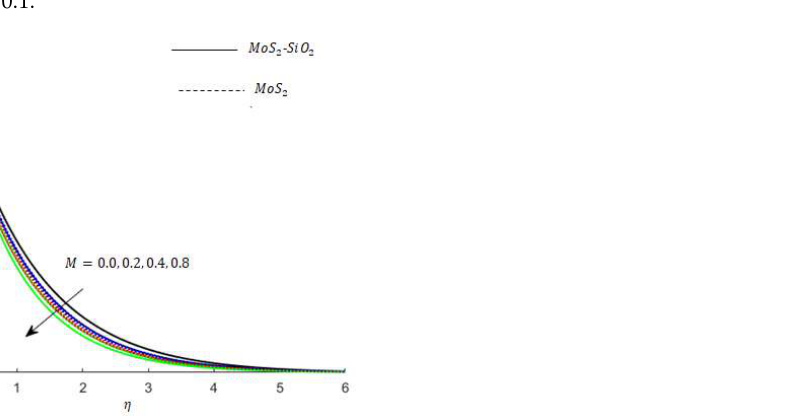
Figure 7. Variation in velocity for 𝑀 when 𝑃𝑟 = 2.36,𝐸𝑐 = 0.01,𝑆𝑐 = 0.8,𝑆𝑟 = 0.1,𝐵𝑖 = 0.05,and 𝛽 ∗ = 0.1.